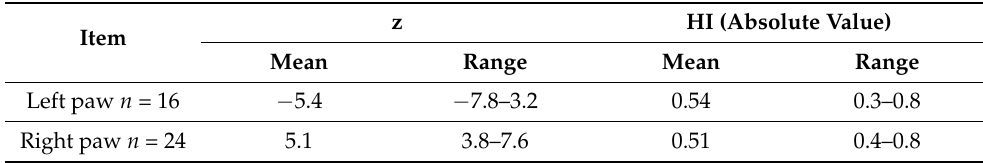
Table 1. Range of the preference index (z) and absolute value of the strength of preference handedness index (HI) for both paws.